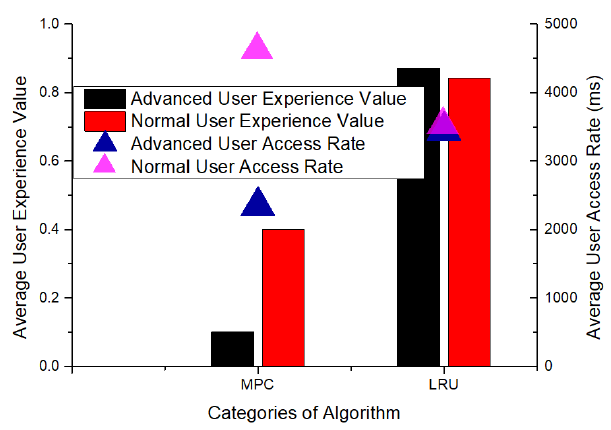
Fig. 7 The performance comparison of different